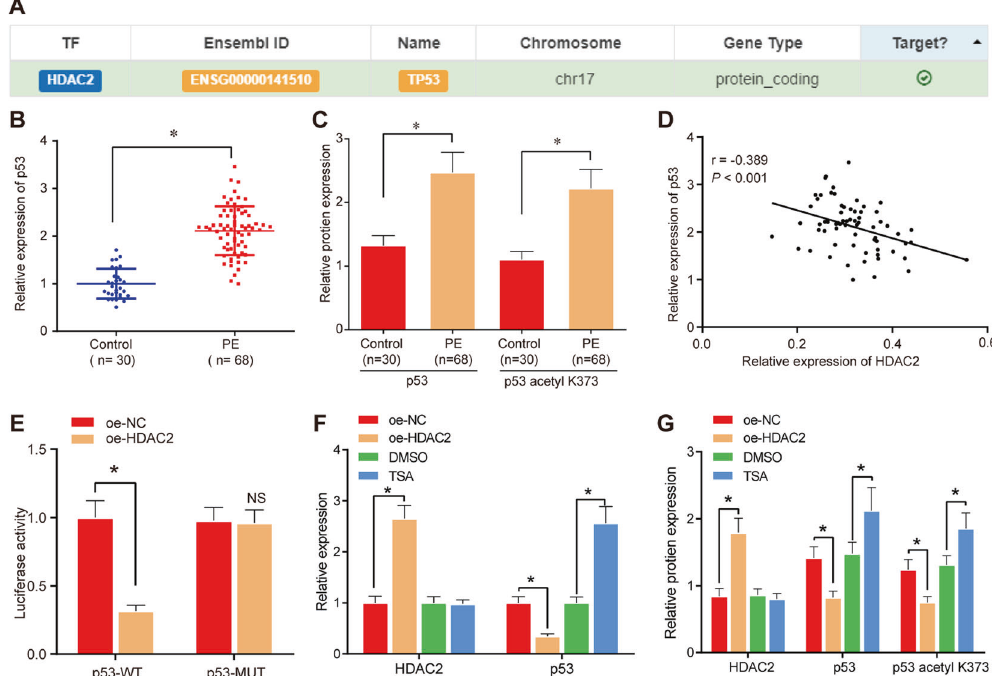
Fig. 3 Overexpressed HDAC2 negatively regulates p53 expression in HTR8/SVneo cells. A hTFtarget prediction on the relationship between HDAC2 and p53 (TP53). B RT-qPCR to detect mRNA expression of p53 in umbilical cord tissues (control n = 30; PE n = 68). C Western blotting to analyze protein-expression level of p53 and p53 Ac in umbilical cord tissues (control n = 30, PE n = 68). D Analysis of the correlation between HDAC2 and p53. E Dual-luciferase reporter gene assay to verify the targeting relationship between HDAC2 and p53 in HTR8/SVneo cells. F RT-qPCR to analyze mRNA expression of p53 in HTR8/SVneo cells 48 h after transfection. G , Western blotting to detect the protein expression levels of p53 and p53 acetyl K373 in HTR8/SVneo cells 48 h after transfection. * p < 0.05 vs. oe-NC or DMSO. The quantitative data were presented as mean ± standard deviation. Difference between two groups was compared using paired t- test. Cell experiments were repeated 3